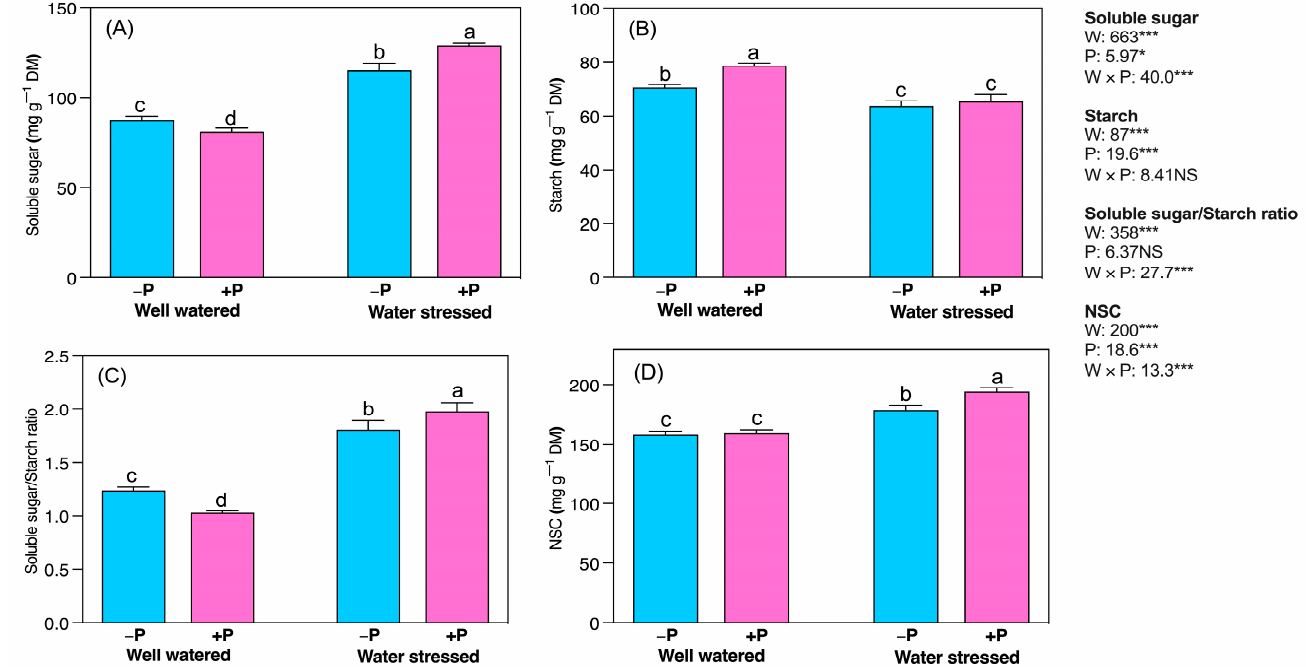
Figure 3. Changes inconcentrations of ( A ) soluble sugar, ( B ) starch, ( C ) soluble sugar/starch ratio, and ( D ) nonstructural carbohydrates in response to P supplementation under well-watered and drought-stressed conditions. A different letter following the means indicates significant differences ( p < 0.05) between the four treatments, as determined by Duncan’s test. Bars represent means ± SD. An overview of the two-way ANOVA assessing the effect of water (W) and phosphorus (P) treatments is presented in the right-hand corner of each panel. * and *** indicate that F values were significant at p ≤ 0.05, 0.01, and 0.001, respectively.